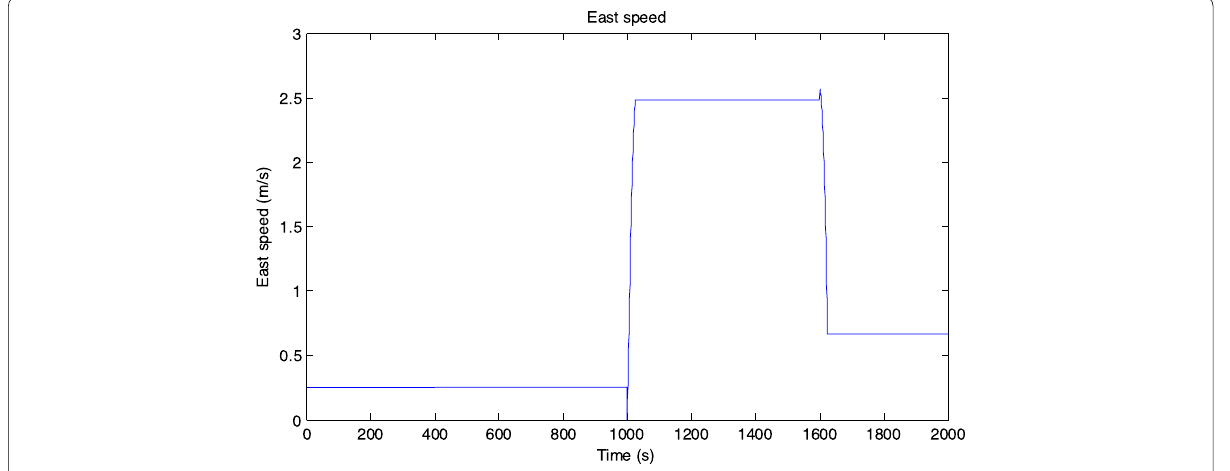
Fig. 8 The motion velocity of evaluation